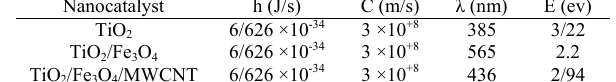
/Fe O / MWCNT 2 3 4